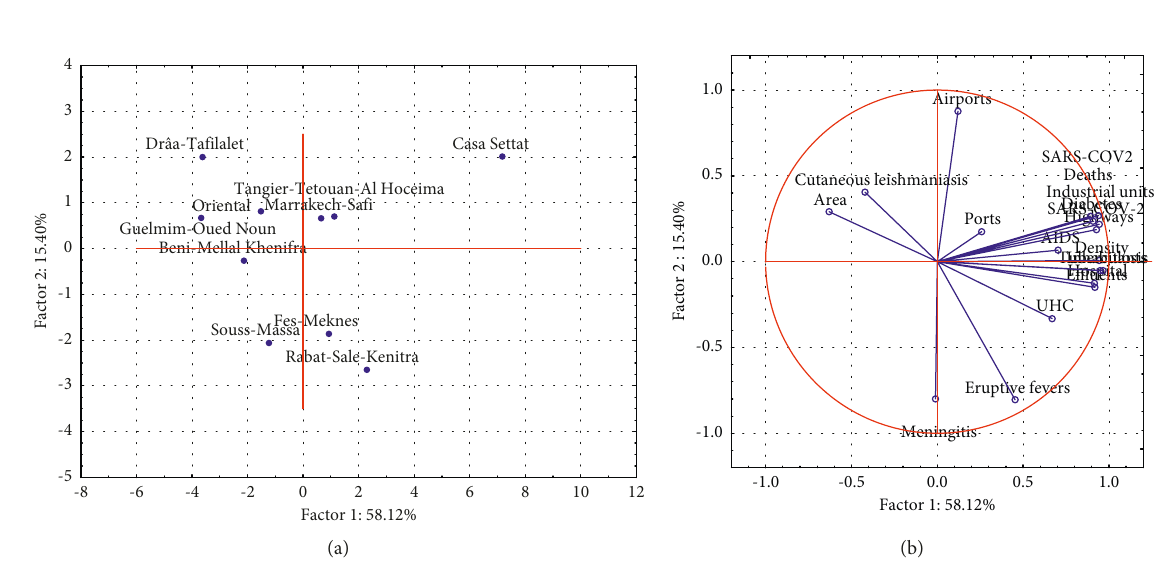
Figure 4: Principal component analysis. (a) The biplot and (b) correlation circle between variables and factors.